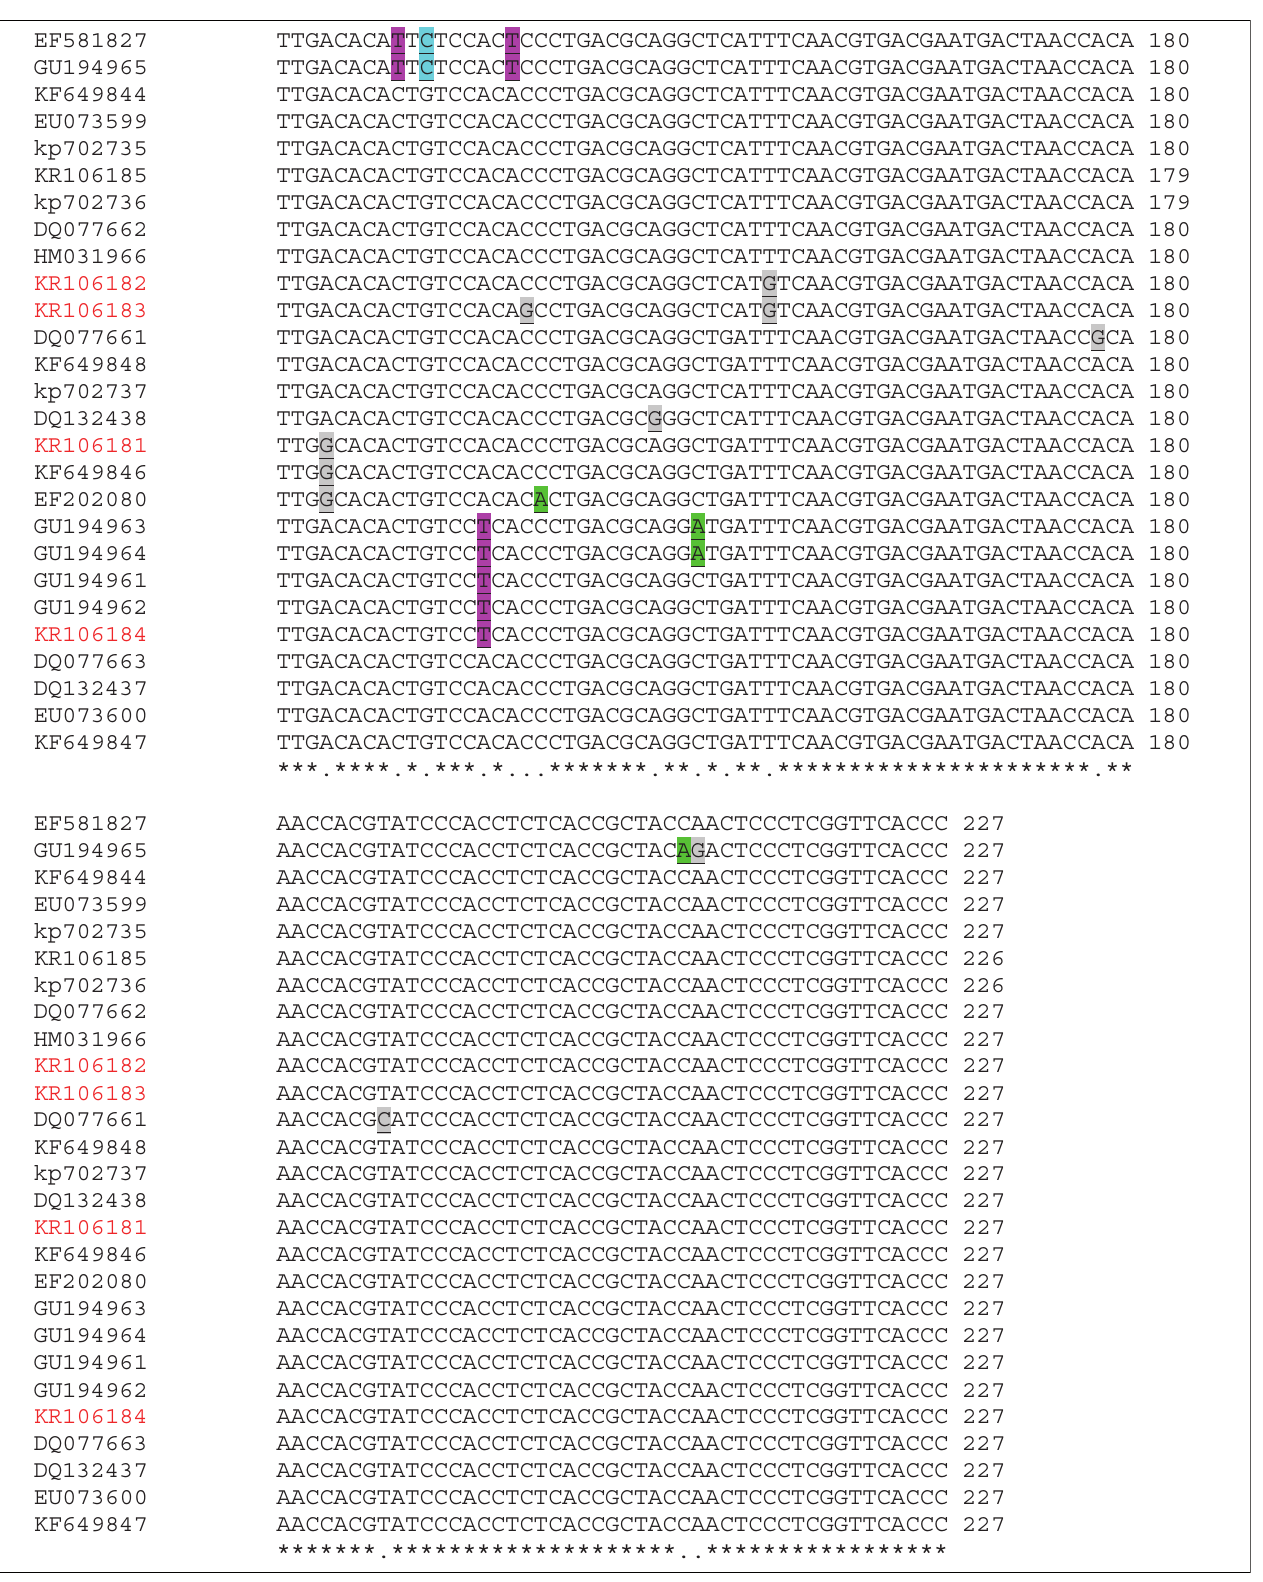
FIGURE 1-A1 (Continues...): Sequence alignment of Nc-5 gene of Neospora caninum from mammalian and bird